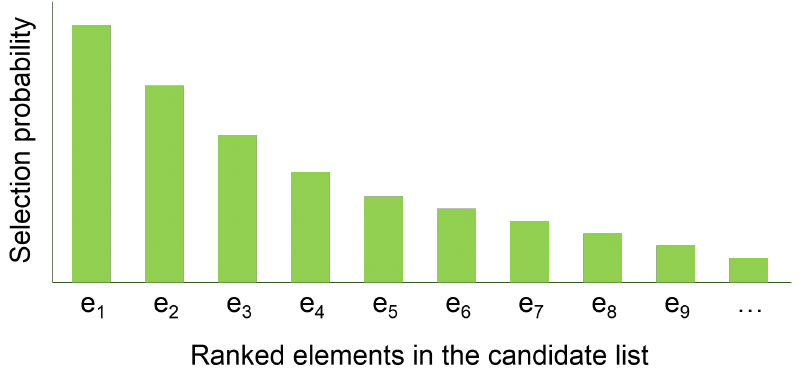
Figure 7. The selection probability of elements in the list of